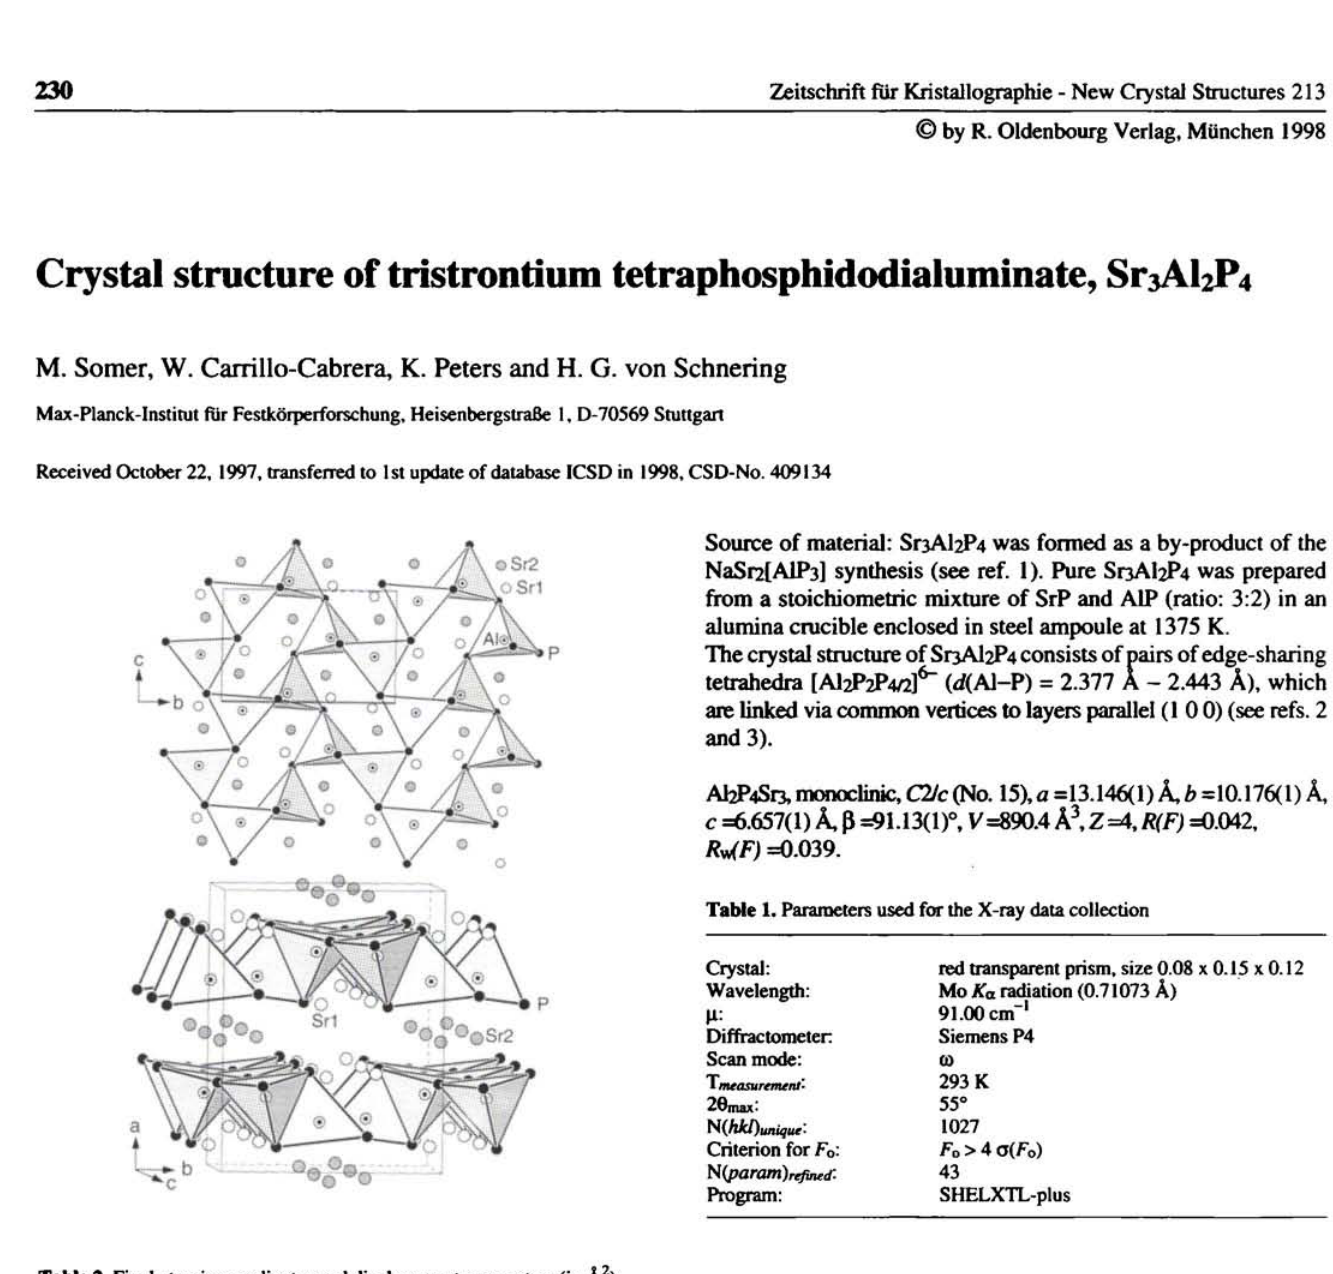
Table 2. Final atomic coordinates and displacement parameters (in